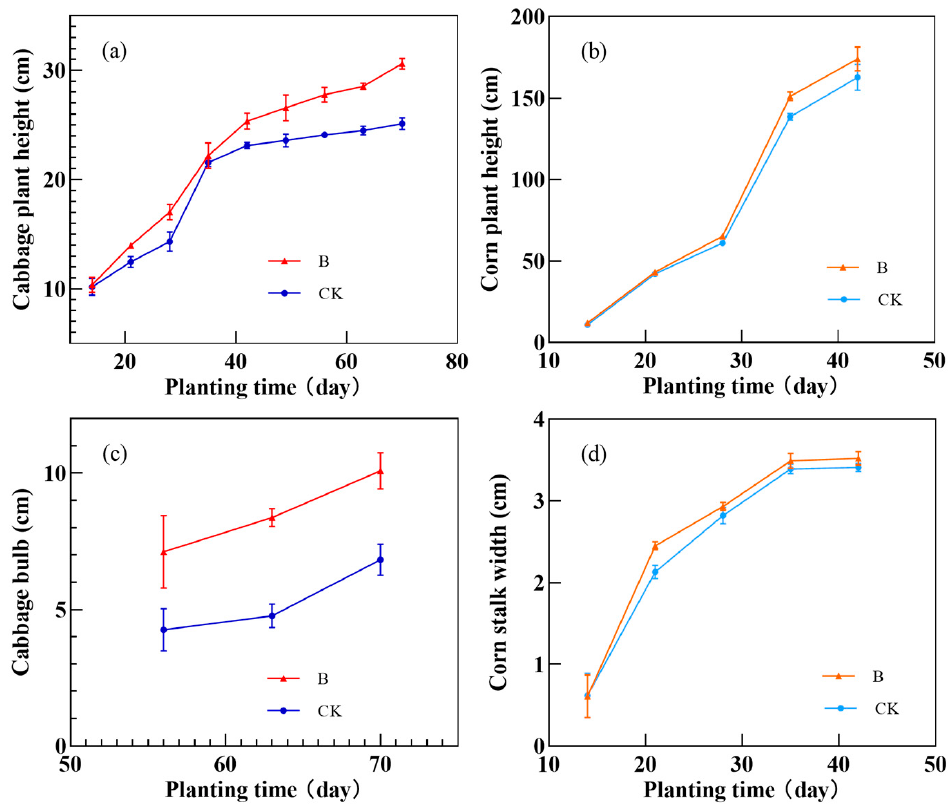
Figure 8. ( a ) Height of cabbage plant; ( b ) height of corn plant; ( c ) bulb of cabbage plant; ( d ) width of corn plant.